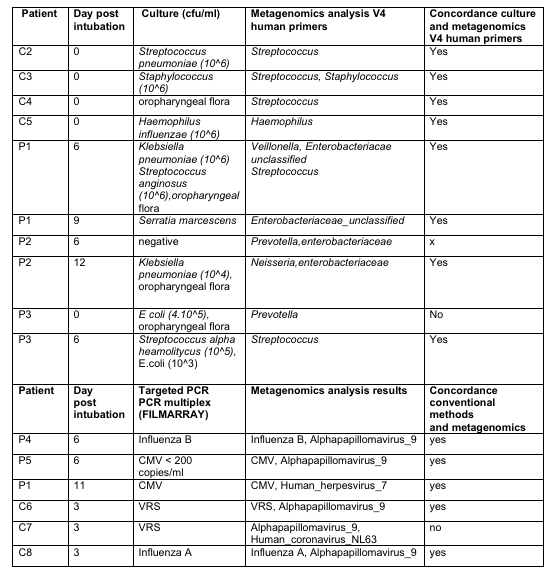
Table 1 Concordance between conventional methods and